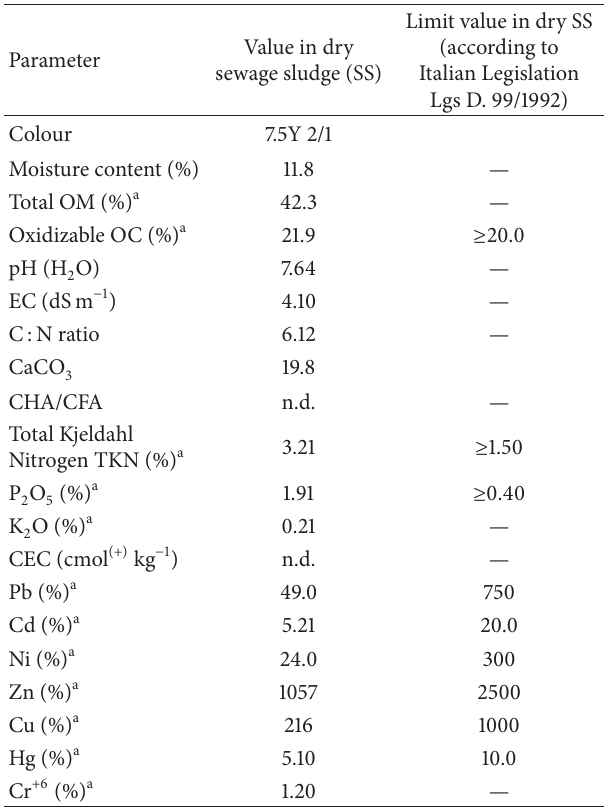
Table 1: Physical and physicochemical characteristics of sewage